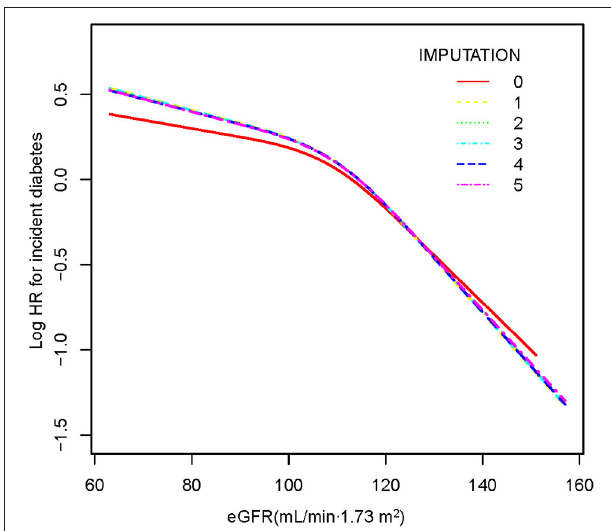
FIGURE 2 | The non-linear relationship between eGFR and incident diabetes. A non-linear relationship was detected after adjusting for gender, BMI, SBP, DBP, FPG, TC, TG, HDL-C, LDL-C, ALT, AST, family history of diabetes, and smoking and drinking status. There were no significant differences between preimputation data and imputed datasets.